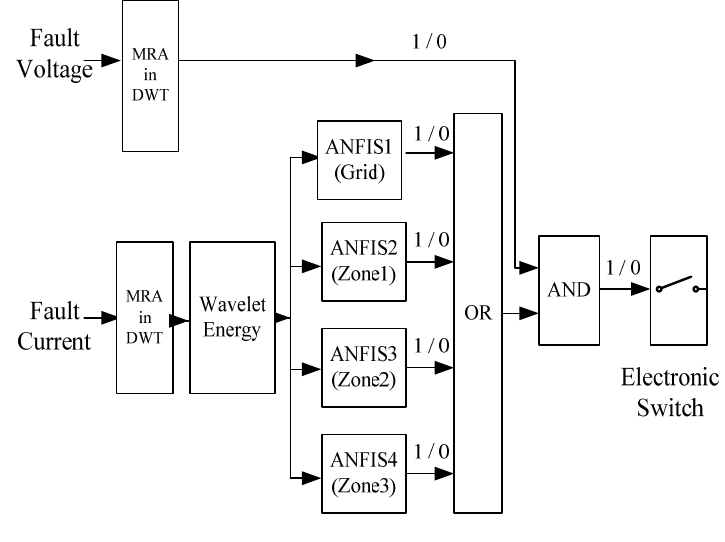
Figure 4. Overall architecture of the two logics. MRA: multi-resolution analysis; DWT: discrete wavelet transform; and ANFIS: adaptive network-based fuzzy inference system.